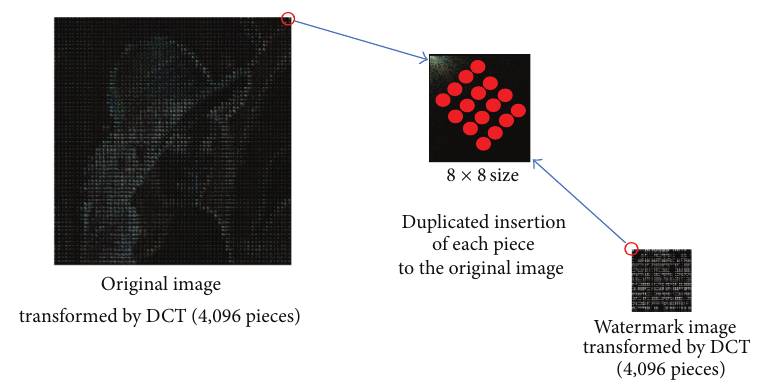
Figure 4: Detailed insertion process of watermark.